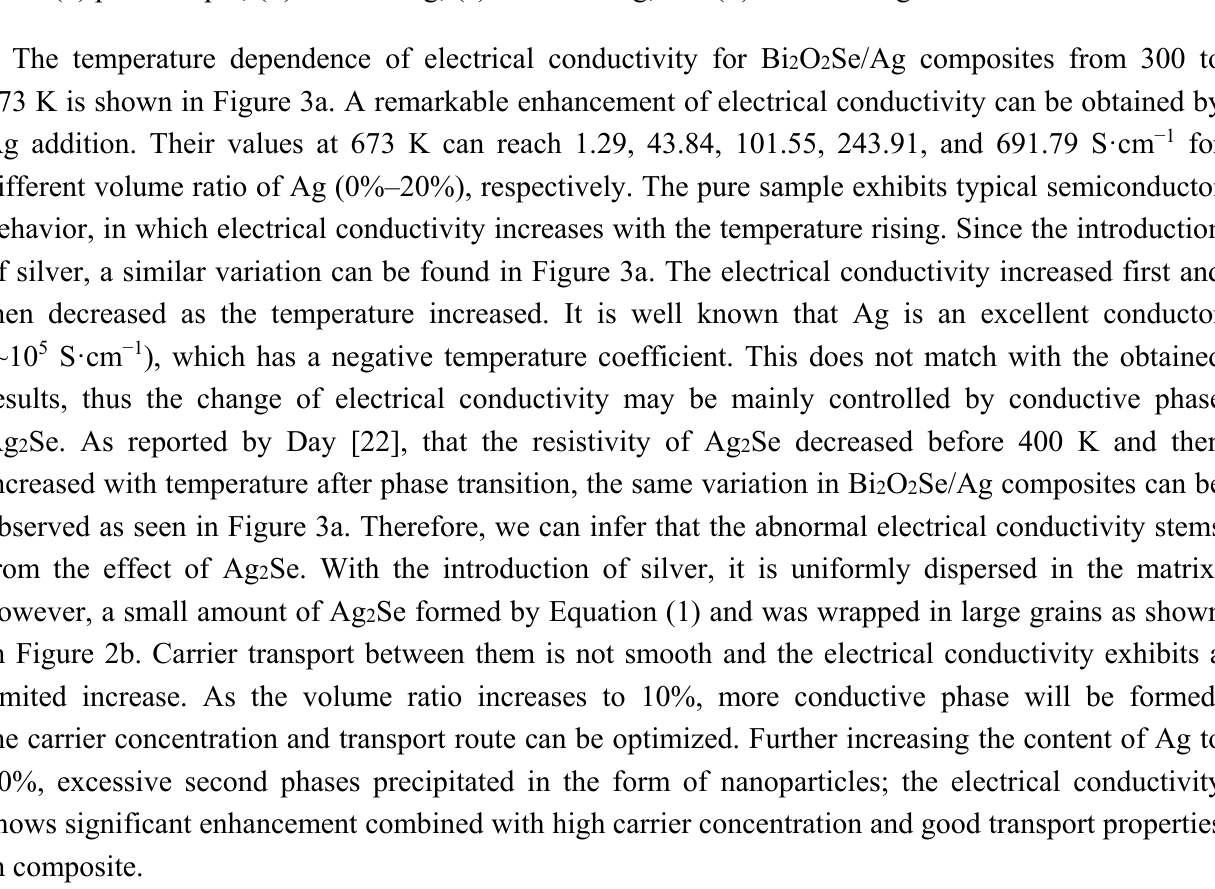
Figure 2. Field emission scanning electron microscopy of Bi 2 O 2 Se/Ag fracture surfaces, ( a ) pure sample; ( b ) 5 vol.% Ag; ( c ) 10 vol.% Ag; and ( d ) 20 vol.%